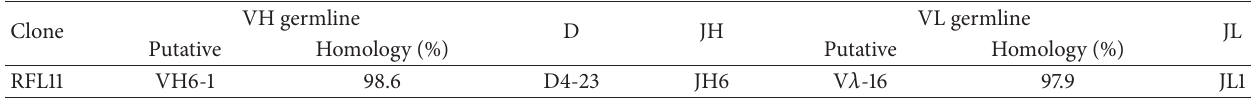
Figure 1: (a) Eluted phage titers after each round of panning. (b) Western blotting analysis of IPTG-induced Fab antibody expression under nonreducing condition. The protein patterns were visualized using goat anti-human 𝜆 light chain antibodies. (c) Randomly selected clones from 4th panned library were examined for their binding to human Fc fragment by ELISA. GG3 and GG48 denoted previously isolated clones expressing recombinant Fab molecules with Fc-binding activity. BL12 and LPSL are negative controls of irrelevant Fab molecules expressed in E. coli . Bound Fab was detected using goat anti-human 𝜆 light chain antibodies. Table 2: Putative germline analysis of Fc-binding clone